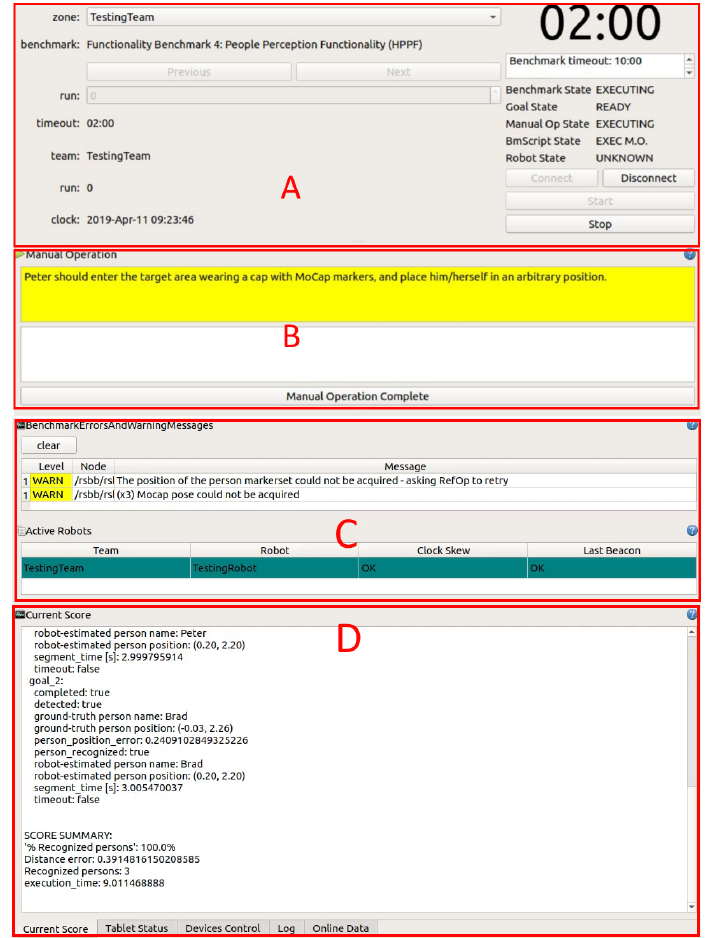
Figure 10. Panels of the RSBB GUI: ( A ) Benchmark control: To select the target robot and benchmark, and to start/stop the benchmark; ( B ) Manual operation: Prints a desired manual action to be executed by the operator, who clicks on the button when it is done; ( C ) Benchmark monitoring: Shows errors/warnings and the currently active robots; ( D ) Score: Displays the current benchmark